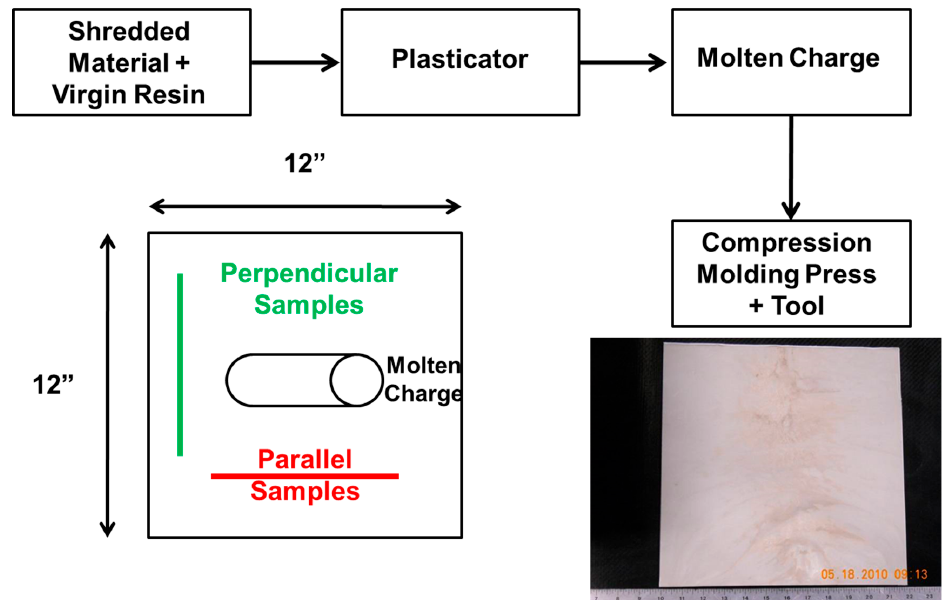
Figure 4. Processing of recyclate, as-received and simple blended recyclate with virgin PP via ECM. Specimens were cut in two directions— Longitudinal and Transverse , respectively, to capture the influence of flow induced fiber orientation. Fibers are preferentially oriented in the Longitudinal direction and cross-oriented in the Transverse direction. The plate is 300 mm × 300 mm (12 ″ × 12 ″ ). Table 2. Verification of fiber weight fraction in recyclate.